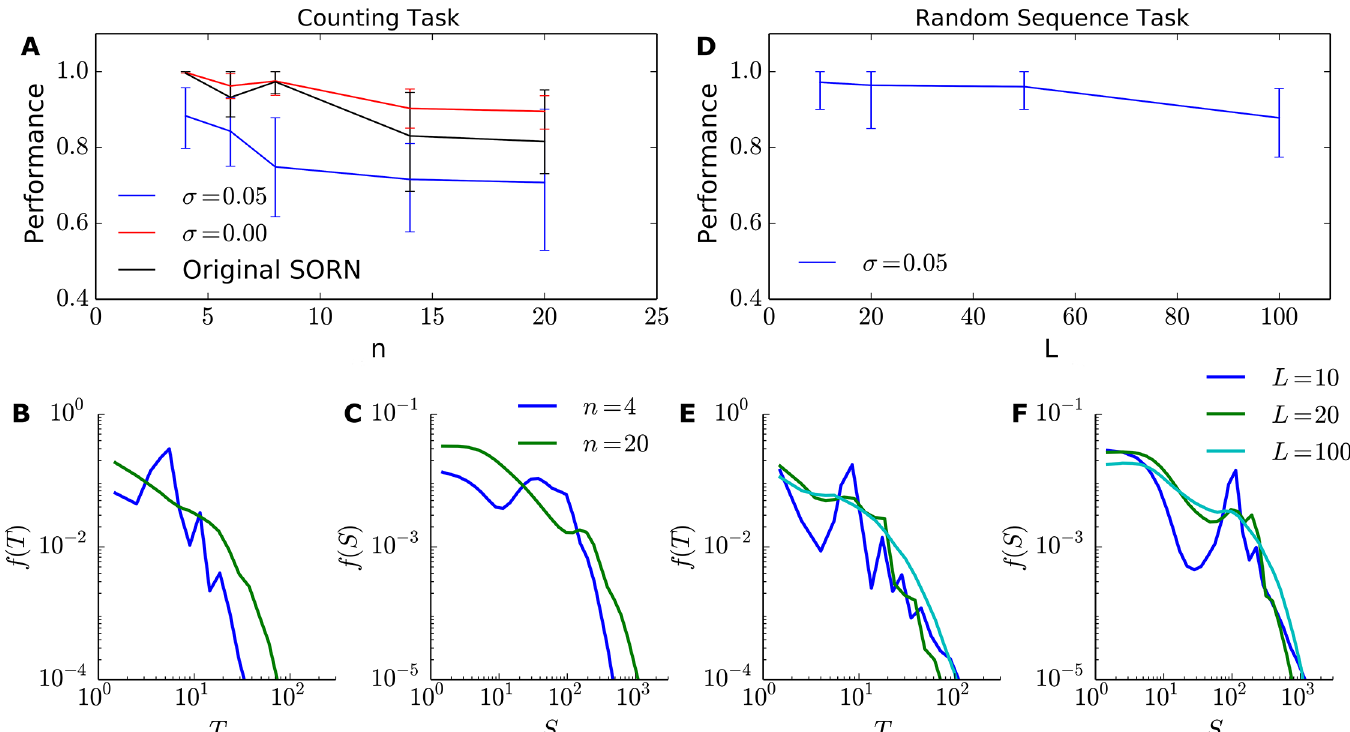
Fig 7. Learning tasks. (A) SORN performance for the CountingTask for sequencesof different sizes, with (blue) and without (red) membranenoise. Original SORN refers to the model without iSTDP, SP and membranenoise, as introduced in [32](B), (C) Durationand size distributions,respectively, duringthe CountingTask for different input sequencesizes n (in the presenceof membranenoise). (D) SORN performancefor the RandomSequenceTask for sequencesof different sizes. (E), (F) Duration and size distributions, respectively,during the RandomSequenceTask for different input sequencelengths L . Curves show the averageof 50 independentsimulations and error bars show the 5%–95%percentile interval.